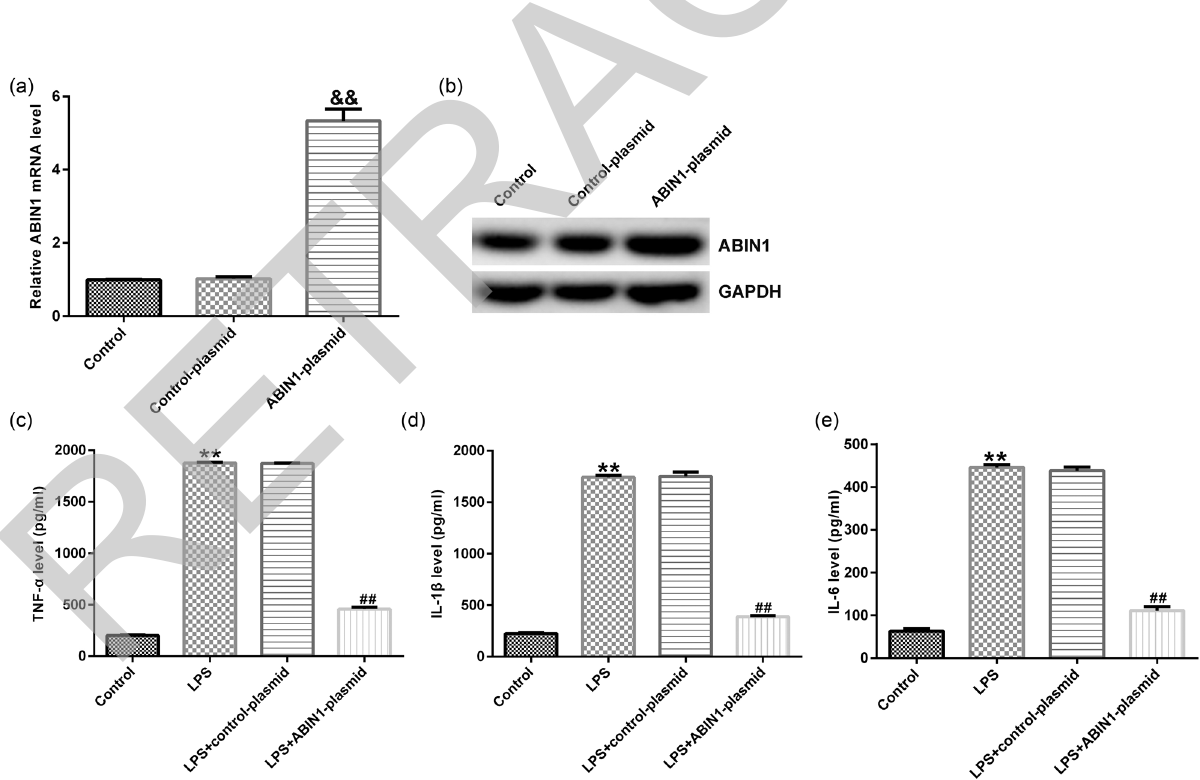
Figure 2: ABIN1 - plasmid reversed the e ff ects of LPS on in fl ammatory factors in macrophages. ( a ) mRNA and ( b ) protein levels of ABIN1 in macrophages after ABIN1 - plasmid transfection. After transfection with control - plasmid or ABIN1 - plasmid, the levels of ( c ) TNF - α , ( d ) IL - 1 β , and ( e ) IL - 6 in di ff erent groups were determined. && p < 0.01 vs control - plasmid; ** p < 0.01 vs control, and ## p < 0.01 vs LPS + control -